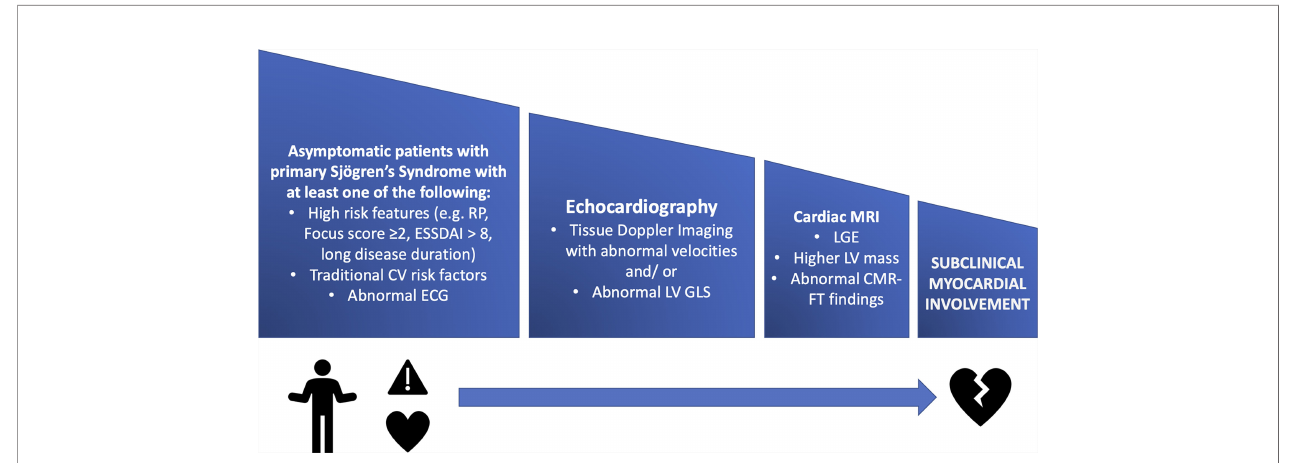
FIGURE 2 | A stepwise approach for screening pSS patients for subclinical myocardial involvement using multimodality imaging. CMR- FT, cardiac magnetic resonance feature tracking; CV, cardiovascular; ESSDAI, EULAR Sjogren ’ s Syndrome Disease Activity Index; GLS, global longitudinal strain; LGE, late gadolinium enhancement; LV, left ventricle; MRI, magnetic resonance imaging; RP, Raynaud ’ s